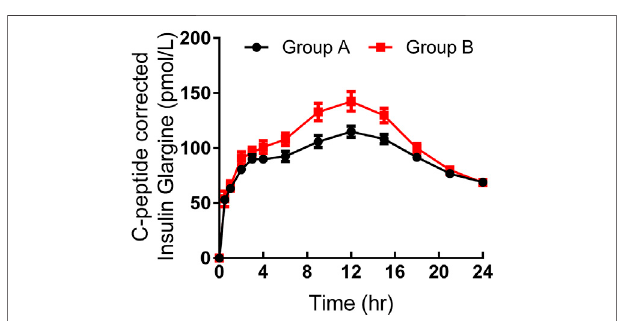
FIGURE 3 | Time-pro fi les of insulin glargine derived from C-peptide correction throughout the euglycemic clamp in groups A and B, respectively (Mean ± SEM).